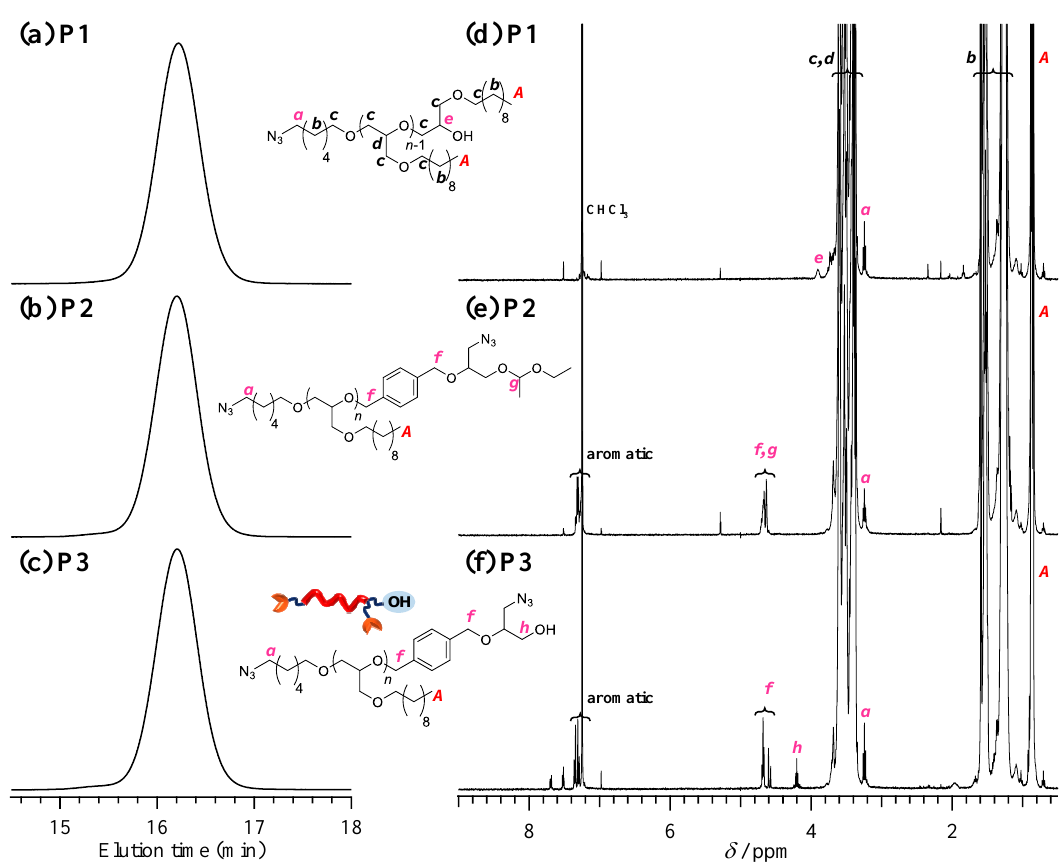
Figure 1. ( a – c ) Size exclusion chromatography (SEC) traces of P1 , P2 , and P3 . ( d – f ) 1 H NMR spectra of P1 , P2 , and P3 in CDCl 3 (400 MHz). Table 1. Characteristics of P1, P2, and